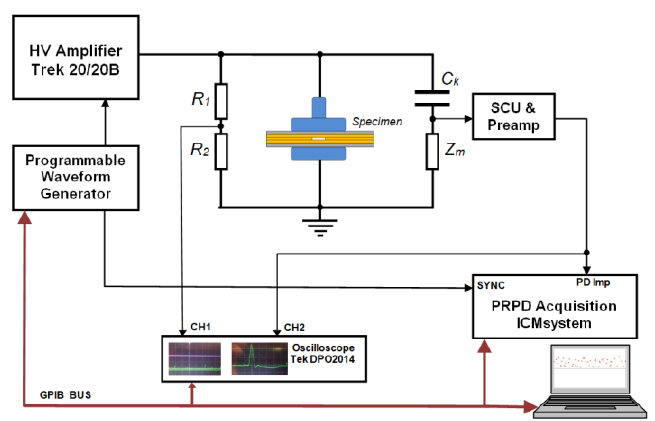
Figure 6. Measuring set-up for PD acquisition at AC and DC voltage: R 1 , R 2 —resistive divider, C k —coupling capacitor, Z m —coupling impedance, SCU—signal conditioning unit and preamplifier.